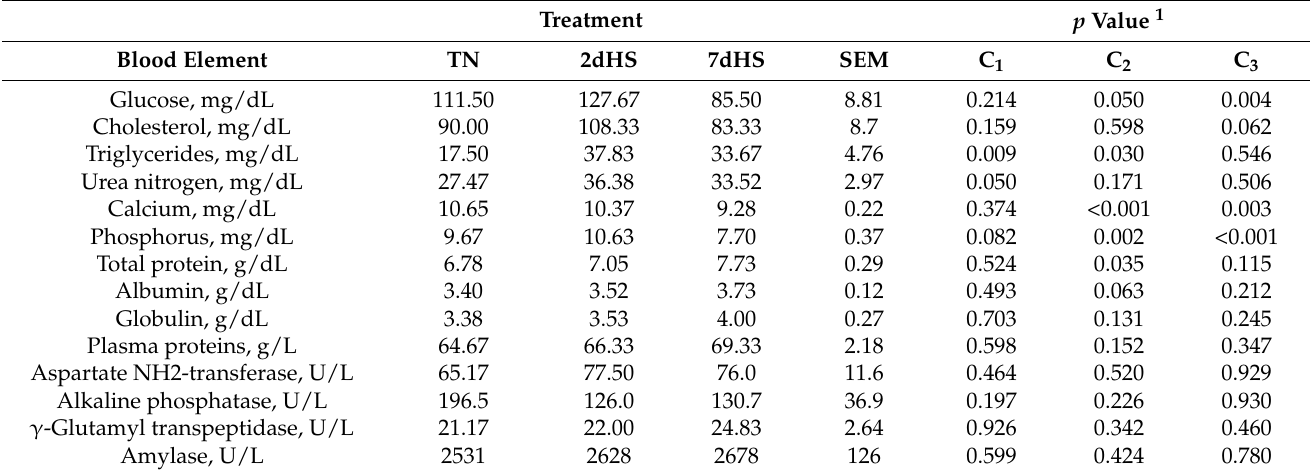
Table 5. Results of blood chemistry of growing pigs under thermal neutral (TN), acute (A-HS), or chronic heat stress